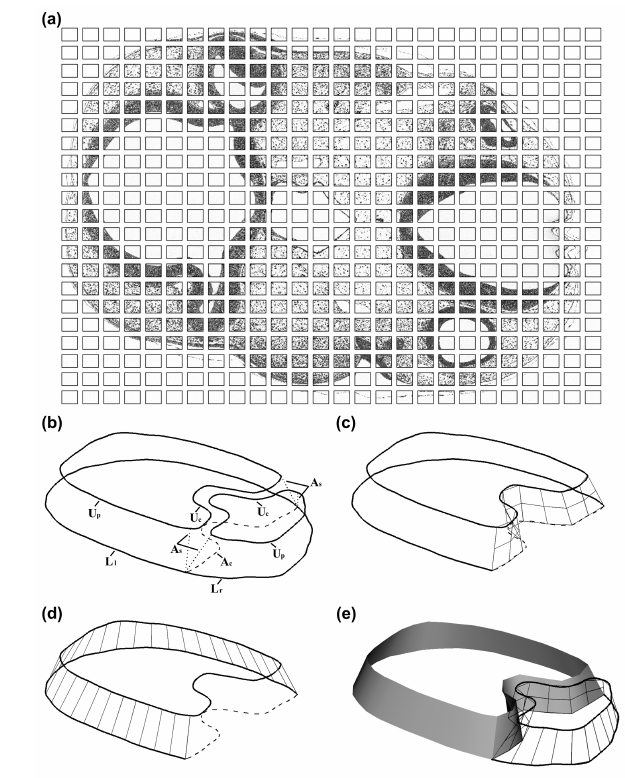
Figure 14. High-resolution scanning and computer-aided 3-D re- constructions of cellular events in the nervous system of Tupaia be- langeri . (a) Composition of a single high-resolution image acquired with the scanning system “Huge Image” from a semithin section (section thickness: 1µm) of a 15-day-old Tupaia embryo. Each of the 546 single small images is scanned with the × 100 objective lens to facilitate structural diagnosis of apoptotic cells. (b–e) In the vector-based software AutoCAD, 3-D reconstructions are created by generating surfaces between corresponding polylines which rep- resent the contours of organ anlagen. (b) To generate surfaces for a y-shaped object, both polylines are split into peripheral ( U p ) and central ( U c ) parts in the upper plane. In the lower plane, a curved auxiliary line ( A c ) divides the polyline into left ( L l ) and right ( L r ) parts. (c) Straight auxiliary lines ( A s ) help to create edge surfaces in central parts of the contours. (d) Next, rule surfaces are generated between peripheral parts of the contours. (e) Following surface gen- eration, surfaces are rendered (left side of the scheme). Reprinted from Süss et al. (2002, Figs. 1a, 5). © 2002, with permission from